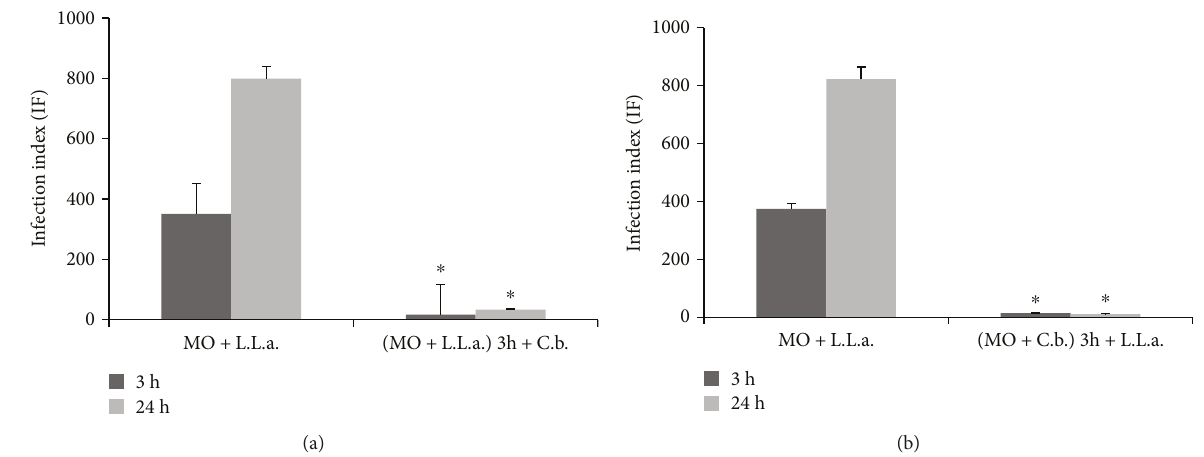
Figure 1: Leishmanicidal activity of Calophyllum brasiliense : 5 × 10 5 macrophages/mL on glass coverslips were (a) infected with L. (L.) amazonensis promastigotes (6 parasites per macrophage) during 3h and treated with hydroalcoholic extract of C. brasiliense (30 μ g/mL) and infection index was obtained after 3 and 24 h of treatment. (b) Cultures were treated with C. brasiliense alcoholic extract (30 μ g/mL) for 3h then they were infected with L. ( L. ) amazonensis , and the infection index was obtained after 3 and 24 hours. Macrophages infected with L. ( L. ) amazonensis and without treatment were controls. ∗ p < 0 05 compared to